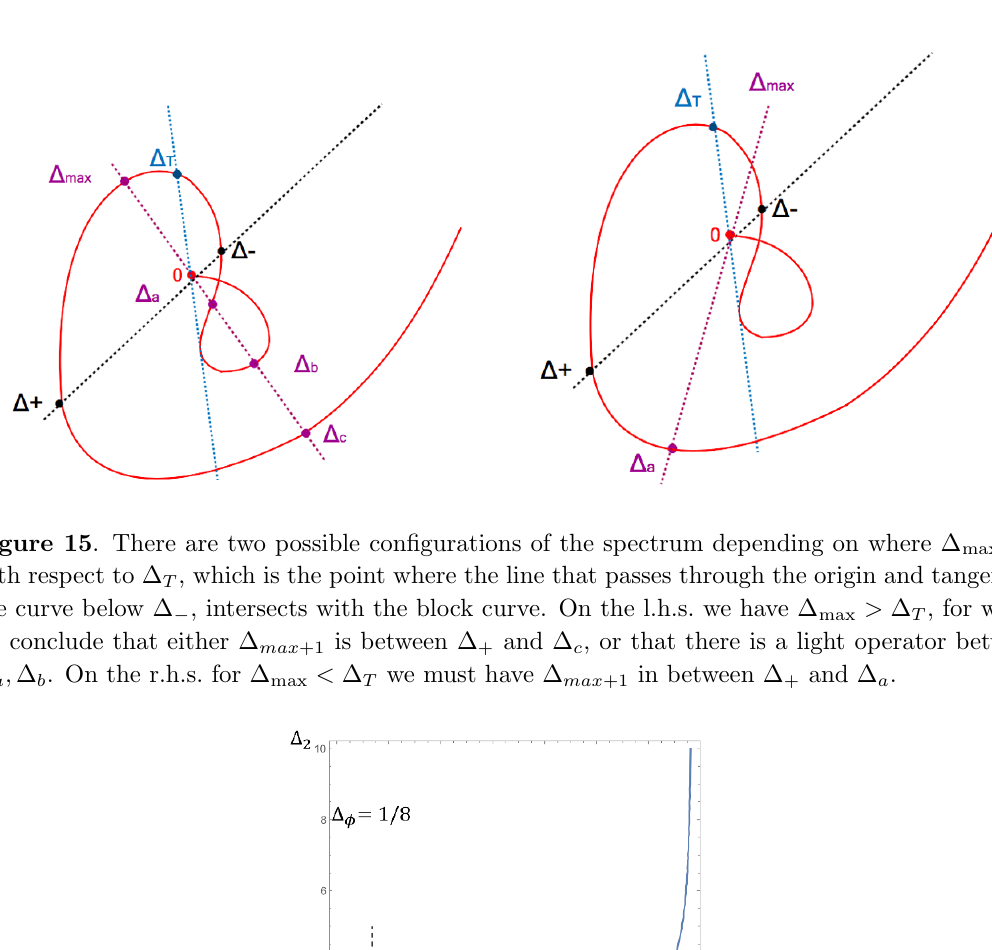
X ; 0 ; (cid:1) 1 ; (cid:1) 2 = 0. Finally for (cid:1) 1 > (cid:1) + h i